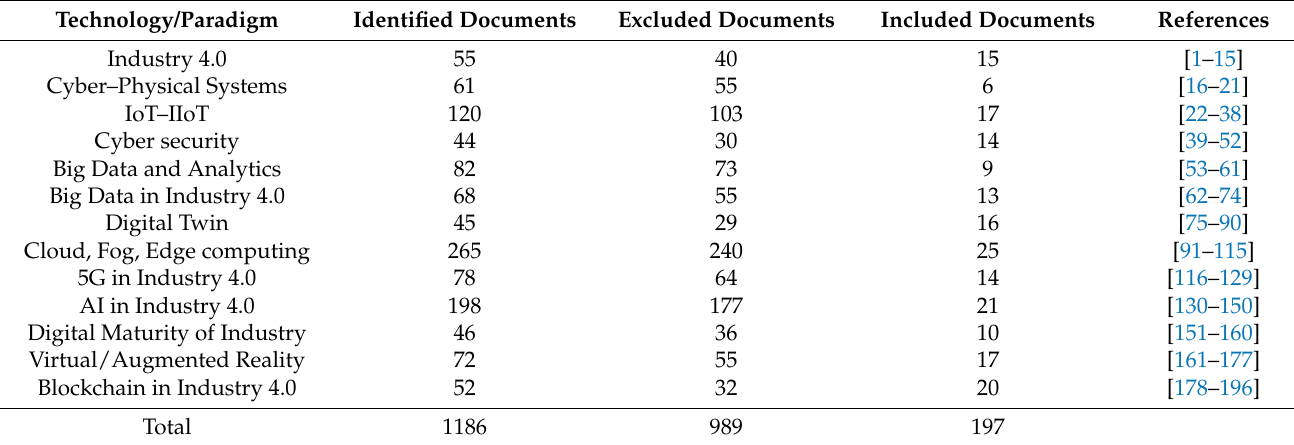
Table 2. Technologies and paradigms of Industry 4.0